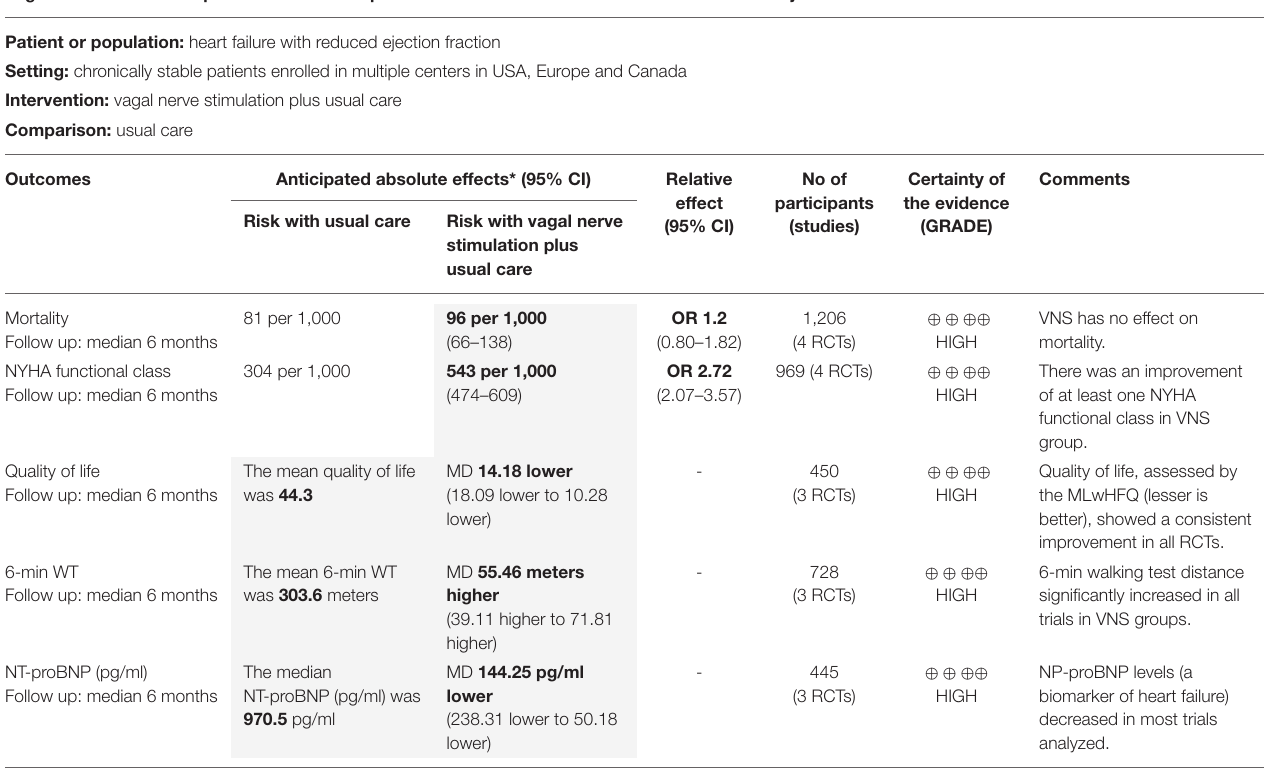
TABLE 3 | Summary of